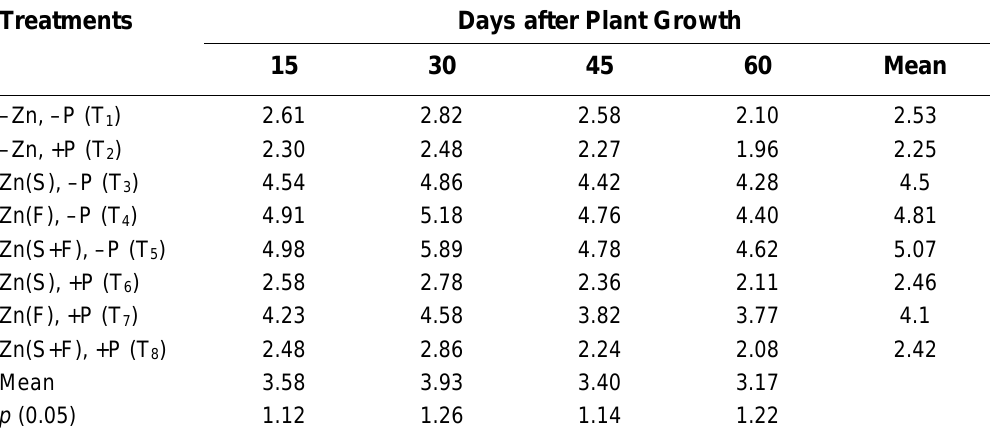
Days after Plant Growth